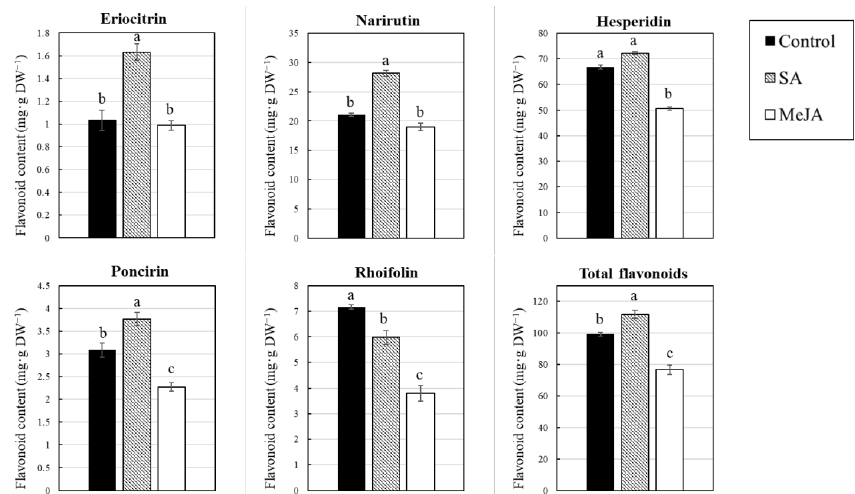
Figure 1. Effect of salicylic acid (SA) and methyl jasmonate (MeJA) treatments on the flavonoid content in the juice sacs of Satsuma mandarin in vitro. The total flavonoid was calculated by summing eriocitrin, narirutin, hesperidin, poncirin, and rhoifolin. Columns and bars represent the means and SE ( n = 3), respectively. Different letters indicate significant differences at the 5% level by Tukey’s HSD test.